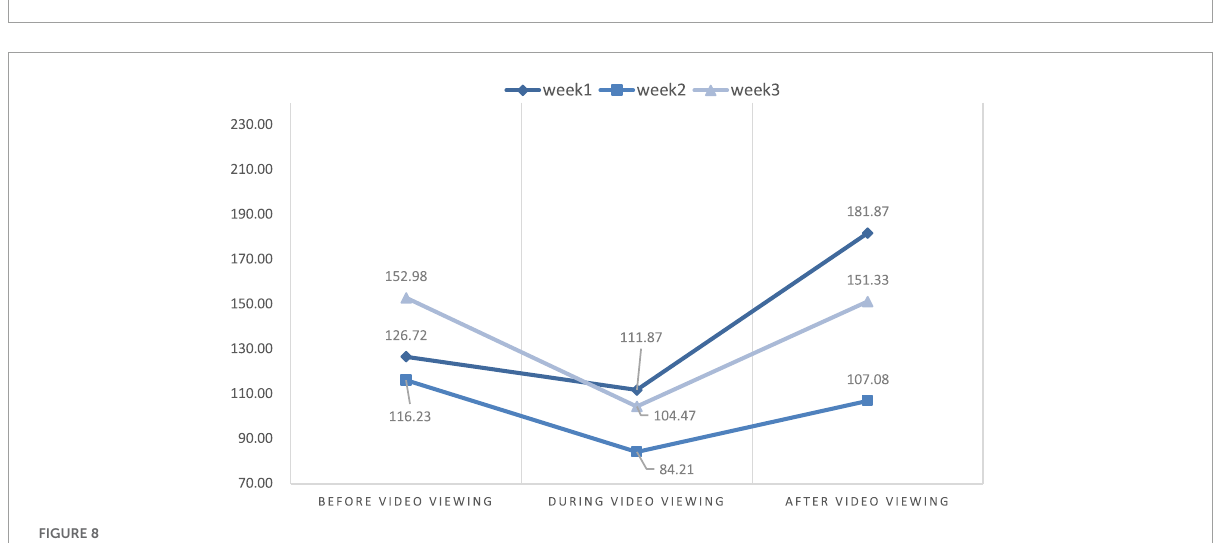
FIGURE7 The mean change of high frequency (HF) parameter.